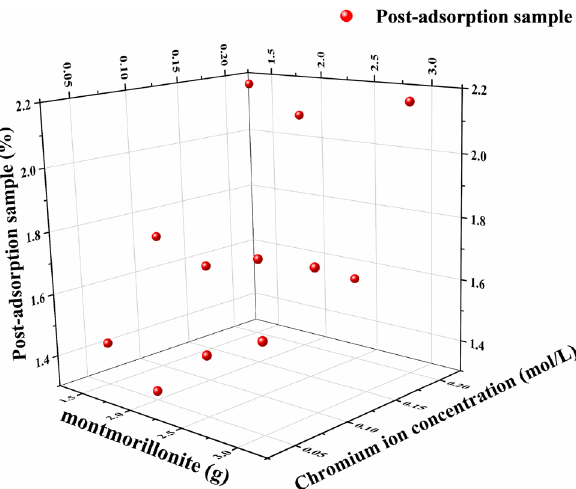
Figure 6. Distribution of the concentration of chromium ions in the samples after absorption. Red spheres correspond to different samples. The experiments were carried out at the temperature of 293.15–298.15 K and the pressure of one